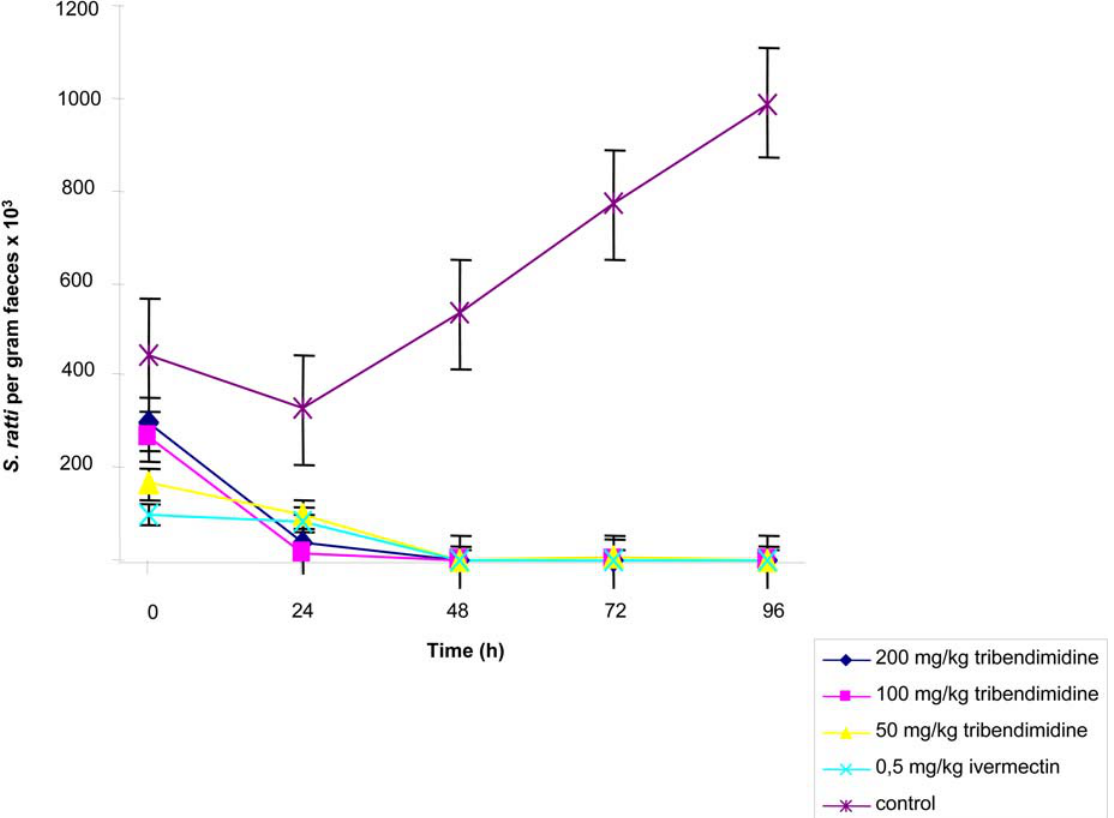
Figure 1. Mean (SE) fecal larvae output of 4 S.ratti -infected rats that remained untreated and 4 S.ratti -infected rats that were treated on day 5 post-exposure with either 0.5 mg/kg ivermectin, or either 50, 100 or 200 mg/kg tribendimidine.